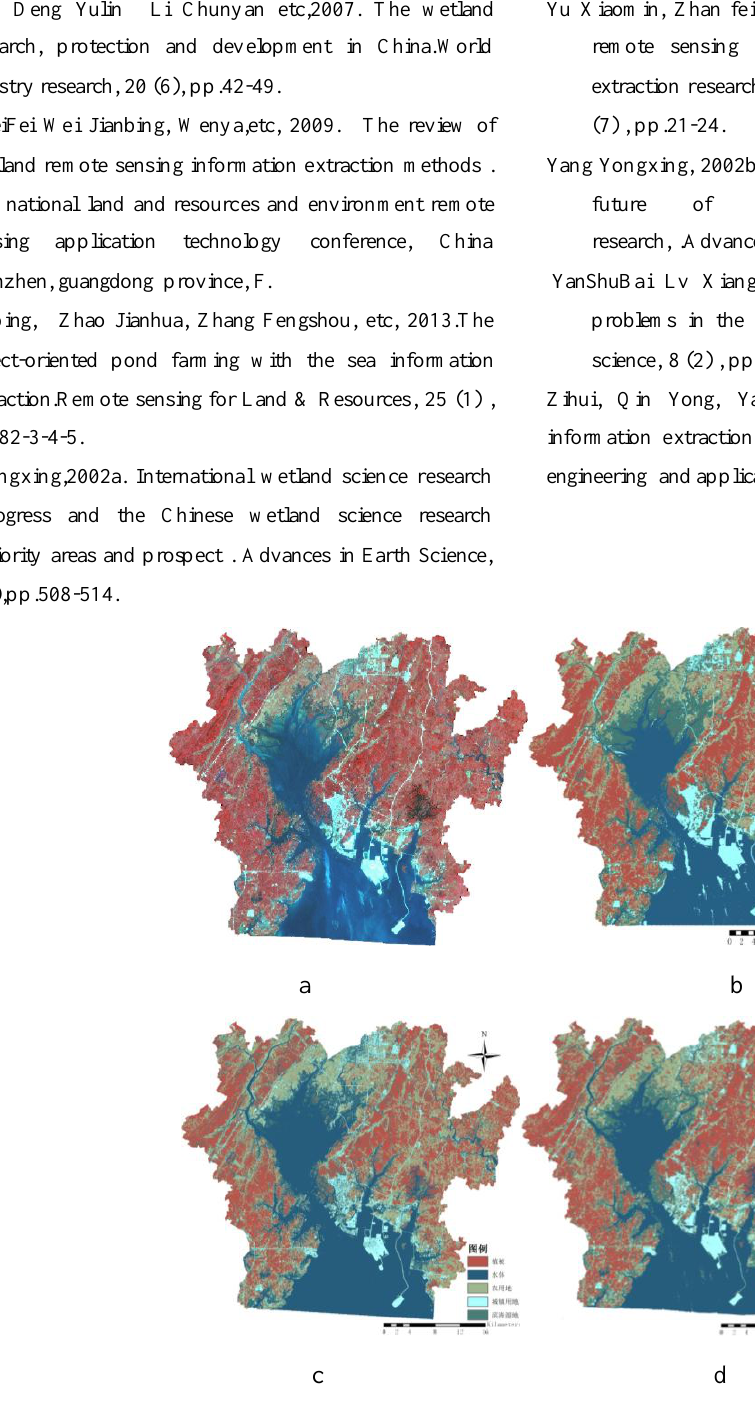
Figure 11. The extraction results